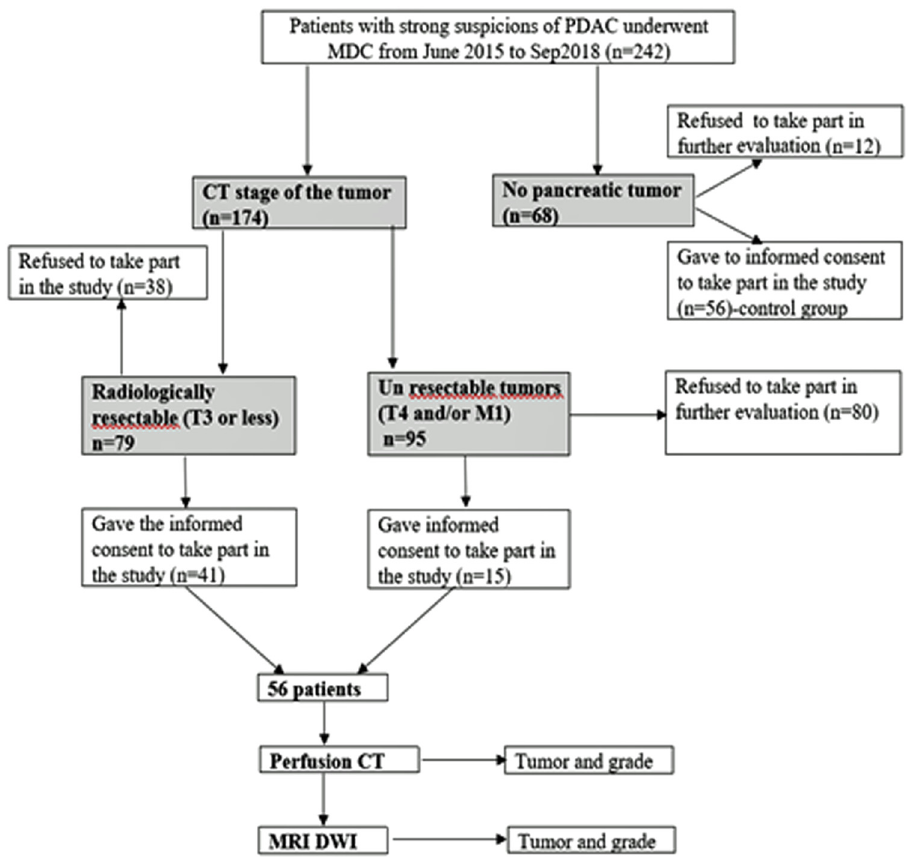
Figure 1: Flowchart of the patient selection